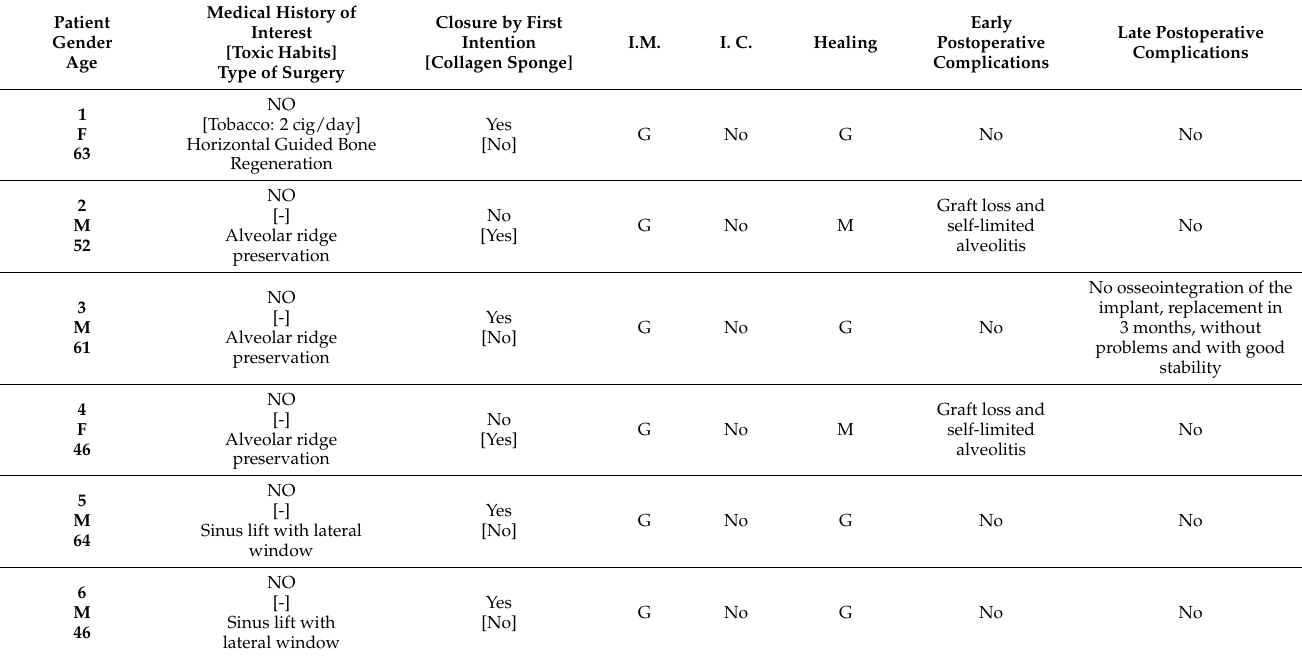
Table 2. Description of the cases. I.M.: Intraoperative management; I.C.: Intraoperative complications; G: Good; M: